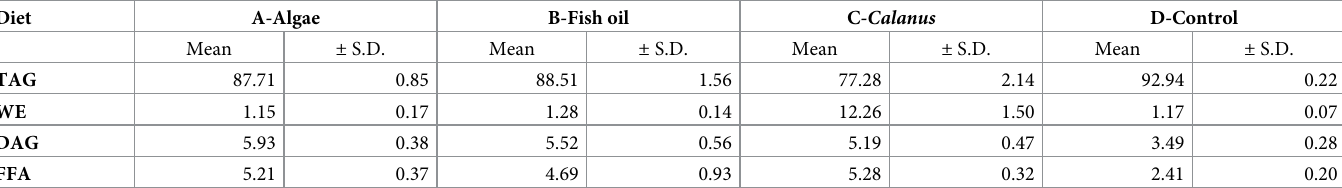
Table 4. Lipid class composition of diets as weight % of total lipid, triacylglycerol (TAG), wax esters (WE), diacylglycerol (DAG), free fatty acids (FFA).